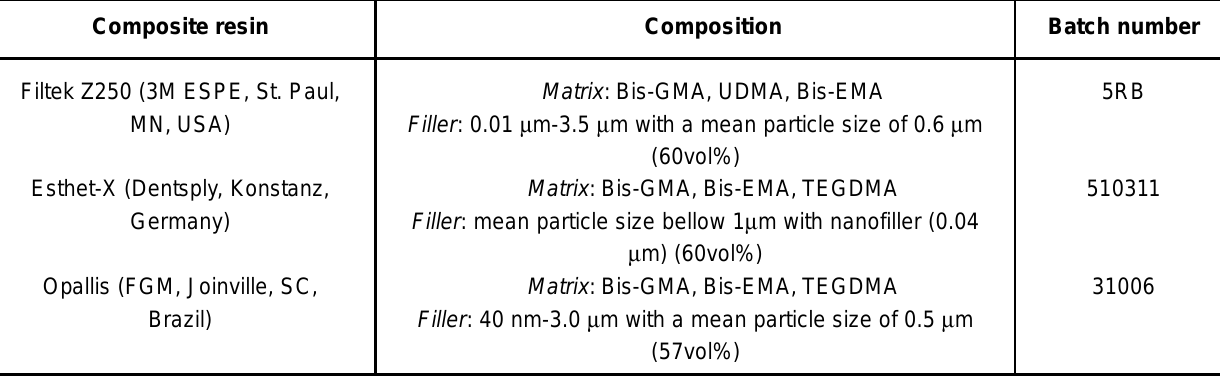
FIGURE 1- Composition of the composite resins evaluated in the